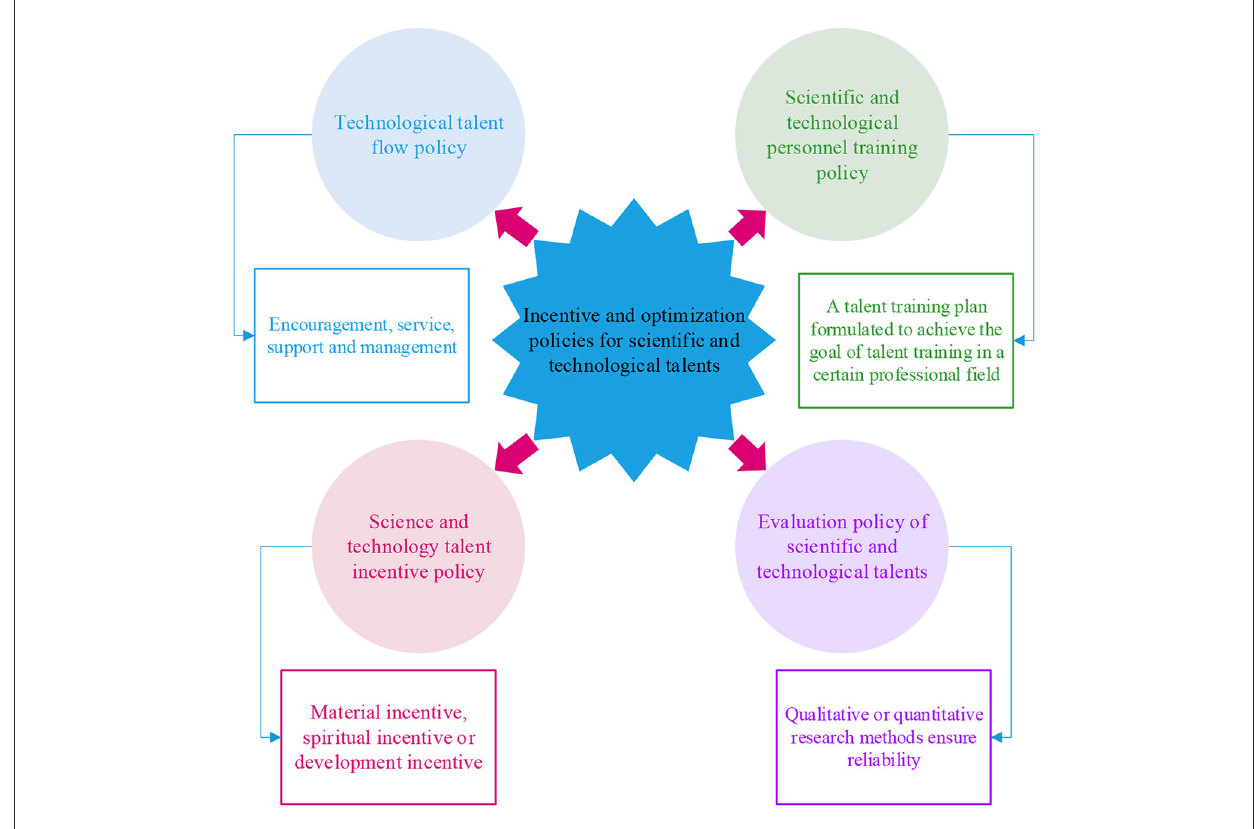
FIGURE1 Classification of the S&T talents